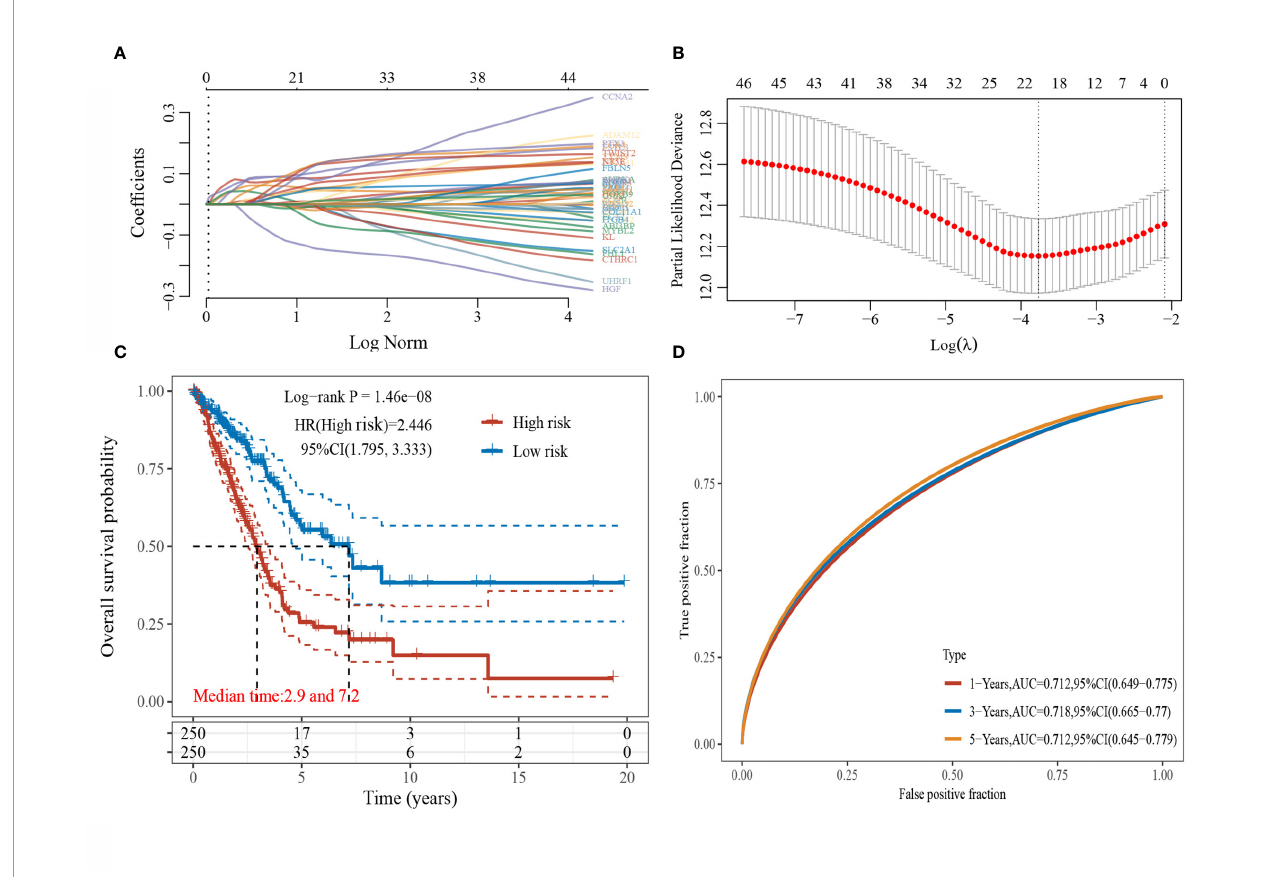
FIGURE 2 | LASSO regression analysis. (A) Coef fi cients of selected characteristics are shown by lambda parameters; (B) Partial likelihood deviation plotted against log(l) using LASSO-Cox regression model; (C) Kaplan-Meier survival plots of high and low risk patients; (D) Time-dependent ROC analysis the gene